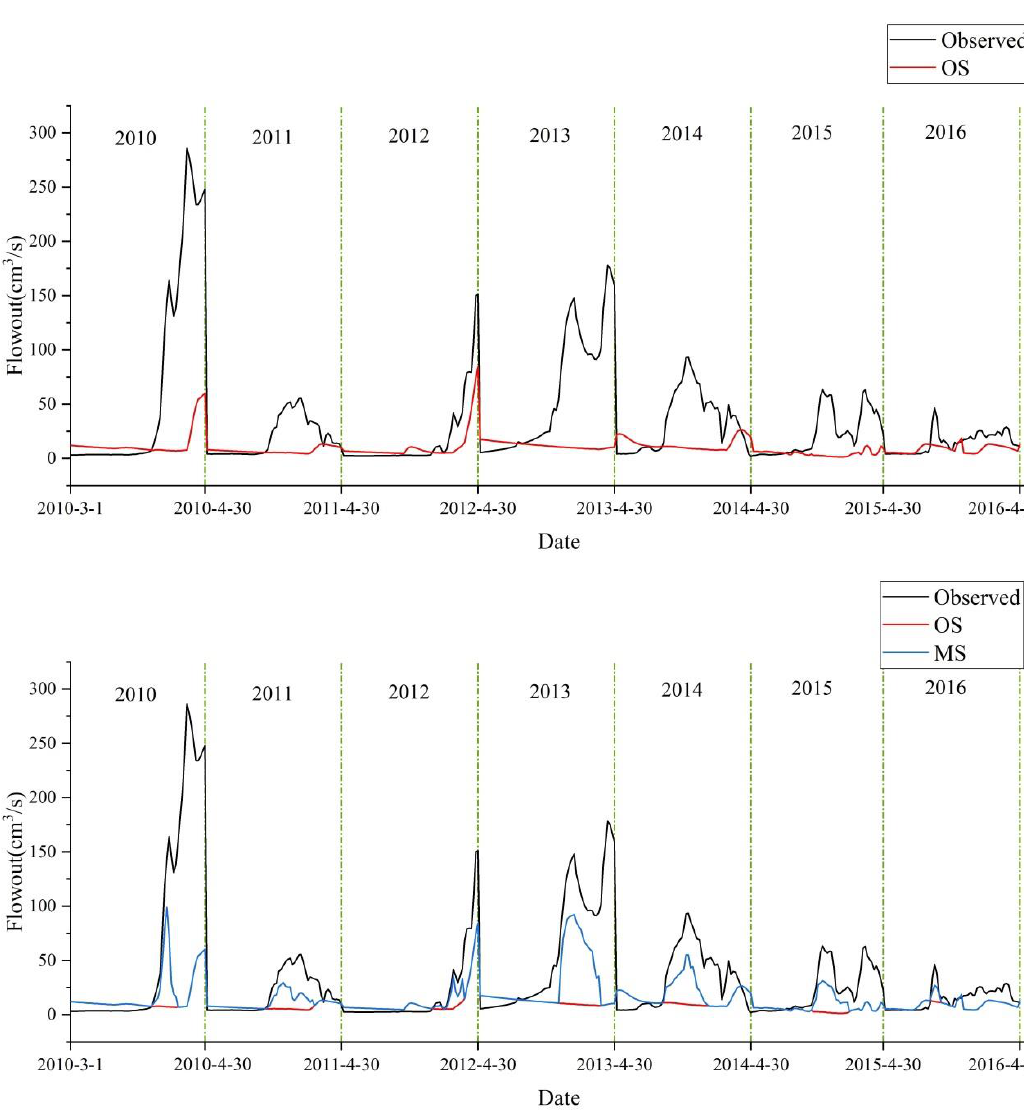
Figure 6. Comparison of two simulation results and observed values （ Date from March 1 to April 30 of each year from 2010 to 2016; OS represents the original simulation and MS represents the modified simulation ） .